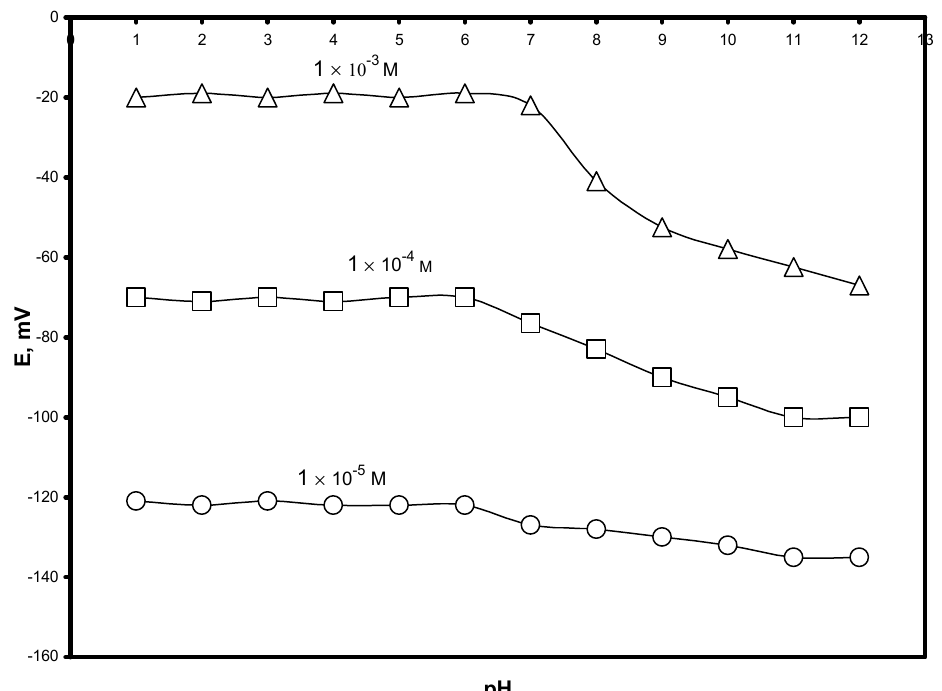
Figure 2.a. Effect of pH on the response of AC-PM membrane sensor using three series of AC solution 1 × 10 -3 , 1 × 10 -4 and 1 × 10 -5